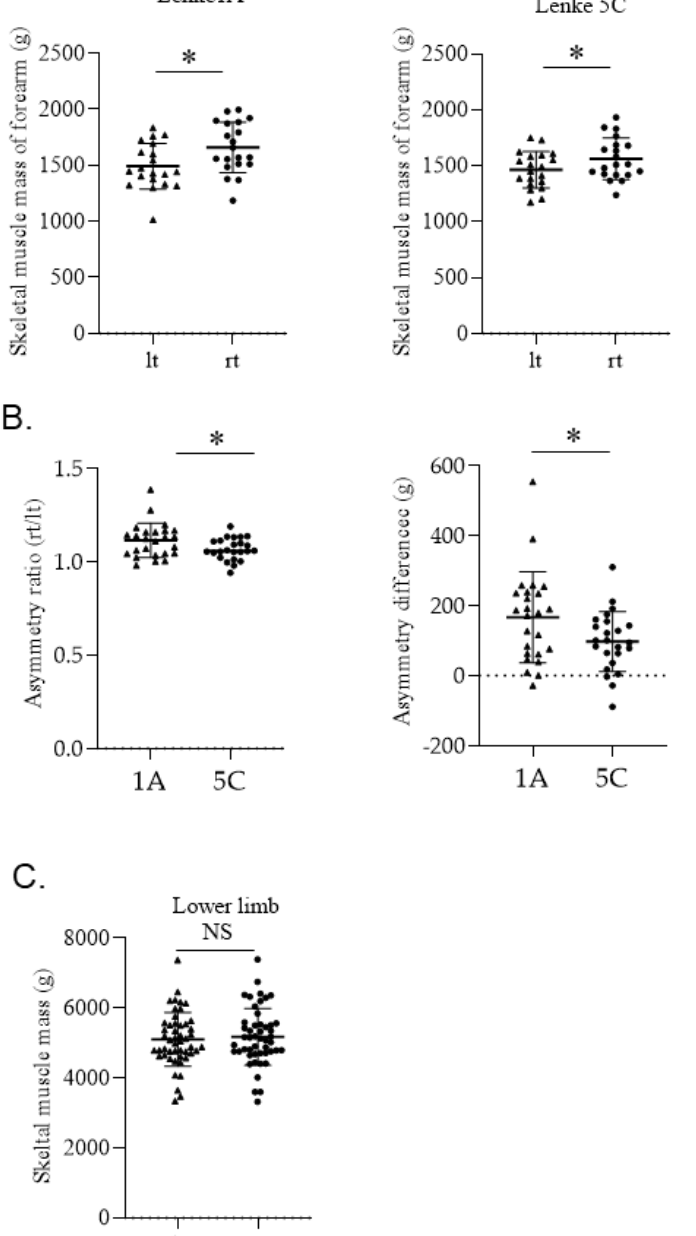
Figure 1. ( A ) Comparison of left and right skeletal muscles of the upper arm in Lenke1A or 5C groups. (* p < 0.005), ( B ) Comparison of asymmetry ratio (rt/lt) and asymmetry difference (rt − lt) for Lenke 1A and 5C groups. (* p < 0.005), ( C ) Comparison of left and right skeletal muscles of the lower limb in all AIS cases. (NS; not significant).